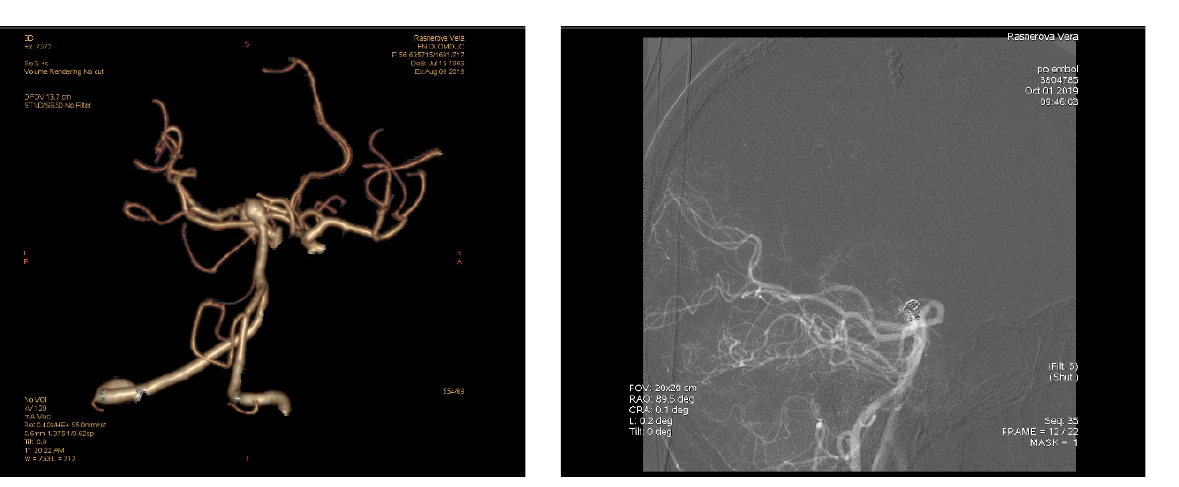
Fig. 1h. Endovascular coil embolization.